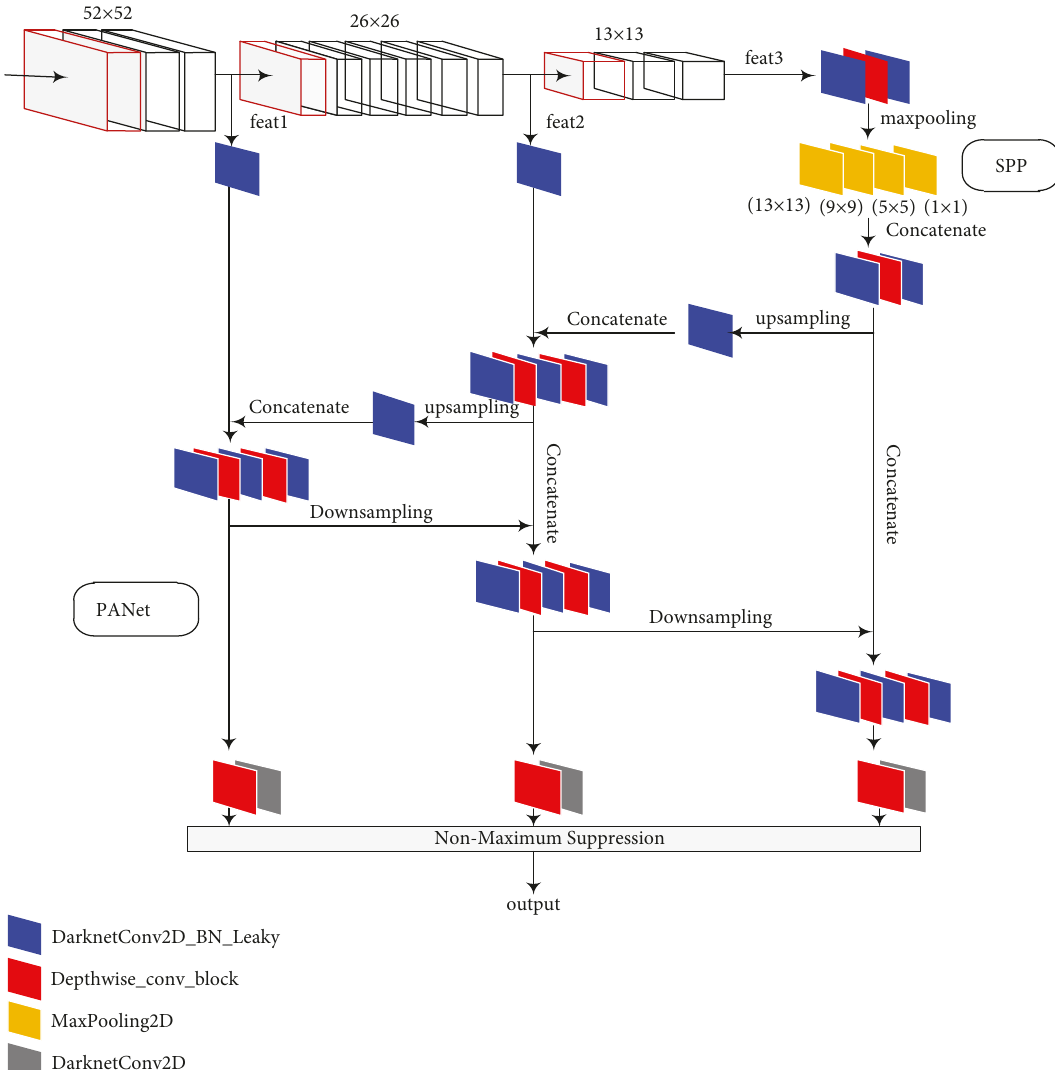
Figure 4: Schematic diagram of the enhanced feature extraction network structure of MYOLO-lite series.